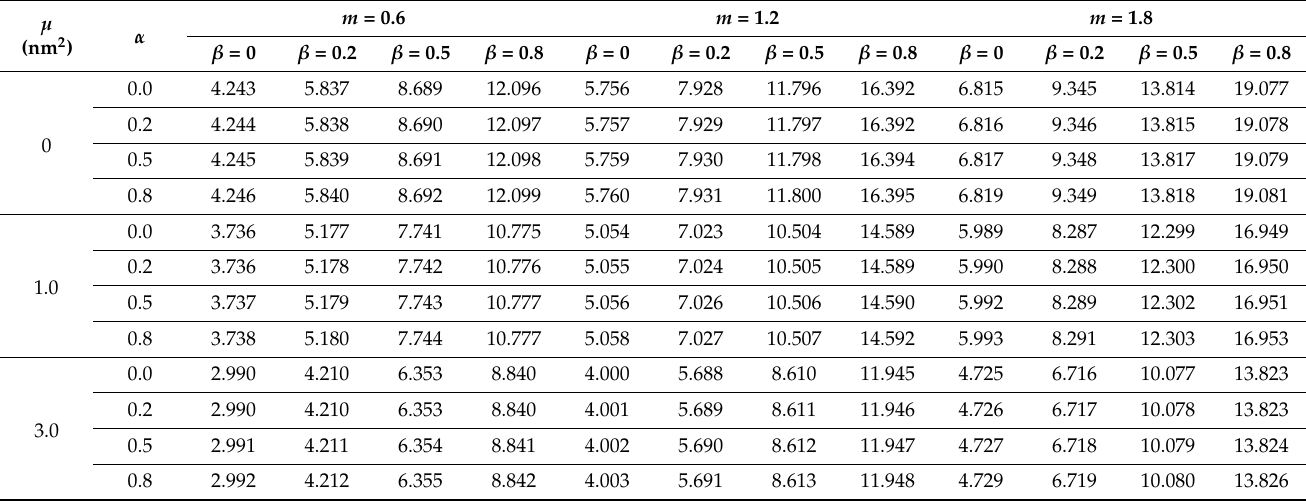
Table 4. Effect of the power-law exponent and tapering parameter on the normalized flexural–torsional buckling load ( P nor ) of simply supported thin-walled nanobeams with different nonlocal parameters (axial load applied on the centroid).